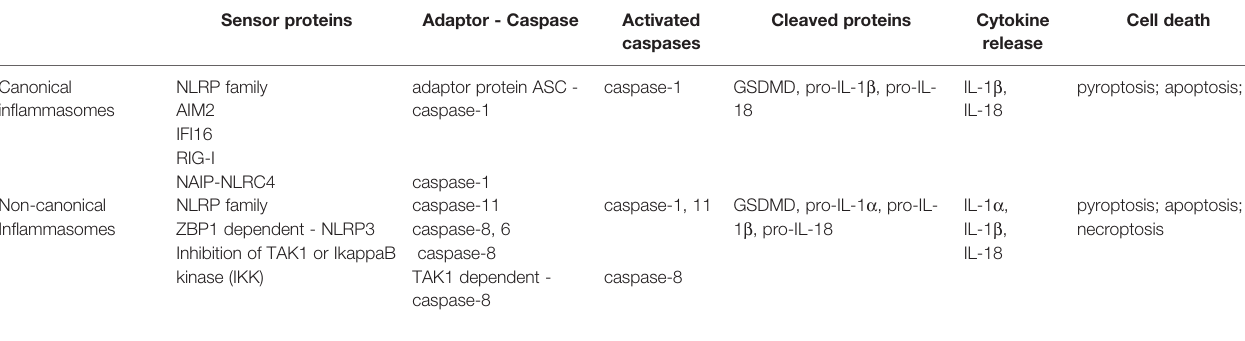
TABLE 1 | Canonical and non-canonical In fl